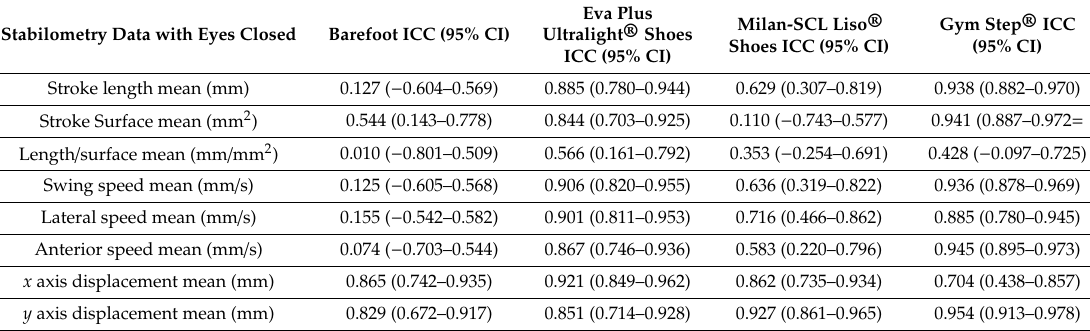
Table 7. Reliability of the stabilometry data with eyes